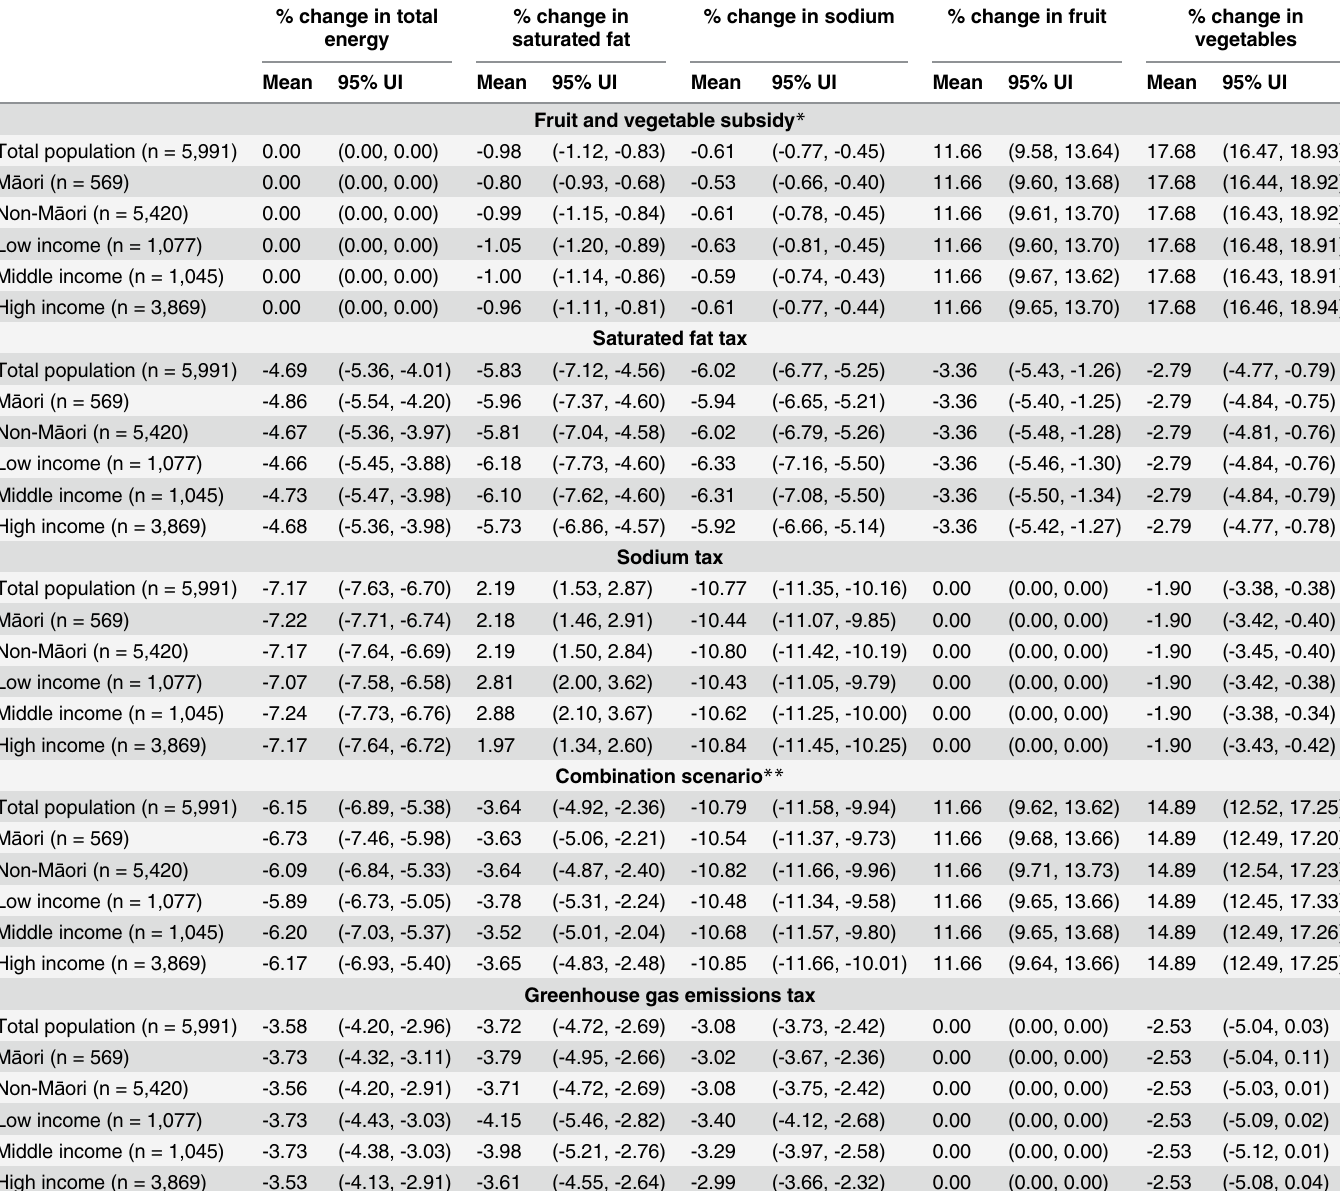
Table 3. Changes in food and nutrient purchases overall and by ethnicity and